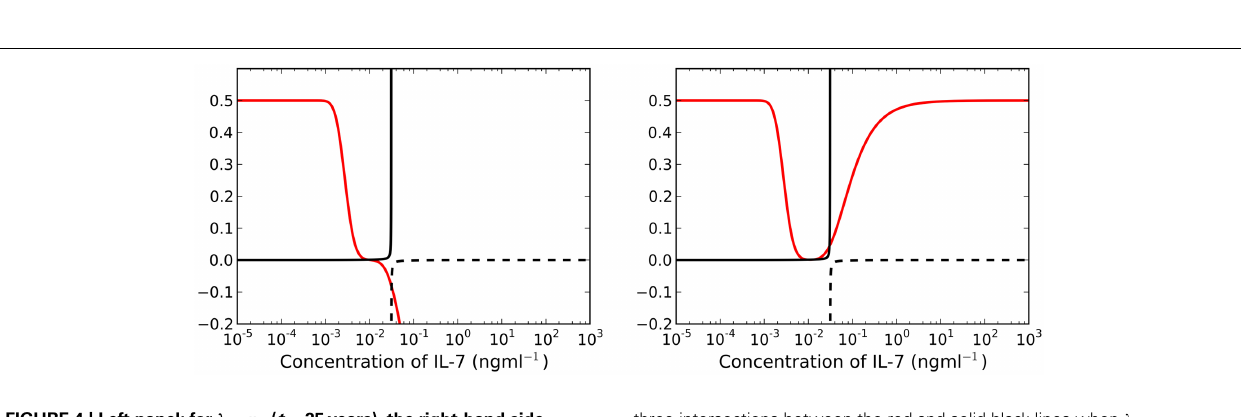
three intersections between the red and solid black lines when λ<µ C for t = 25years.We require β( t ) > γ( ˆ I ( t )) for existence of stable solutions, therefore we neglect all intersections with the dashed black line.